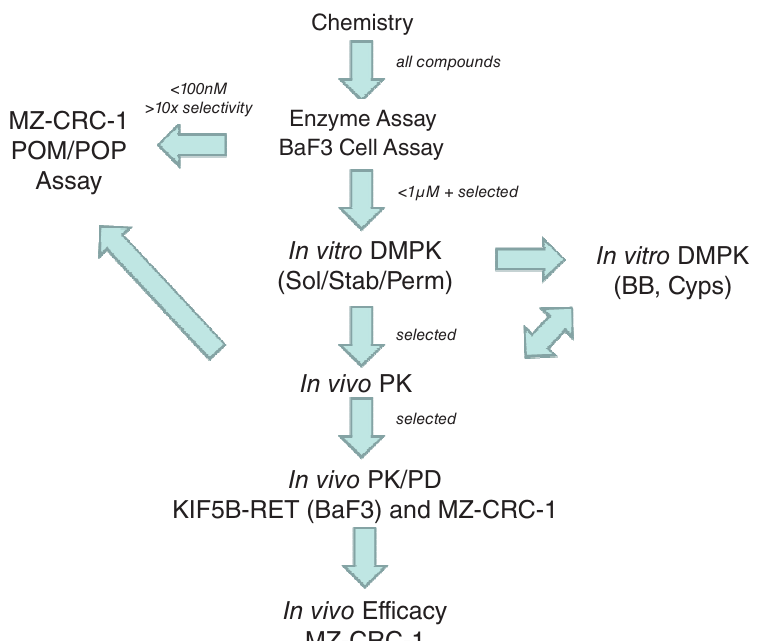
Figure 4. Current screening cascade (and selection criteria) for identification and development of potent and selective (vs KDR) RET inhibitors. Arrows represent compound flow. Sol = solubility, Stab = stability, Perm = permeability, BB = Blood-binding, Cyps = Cytochrome